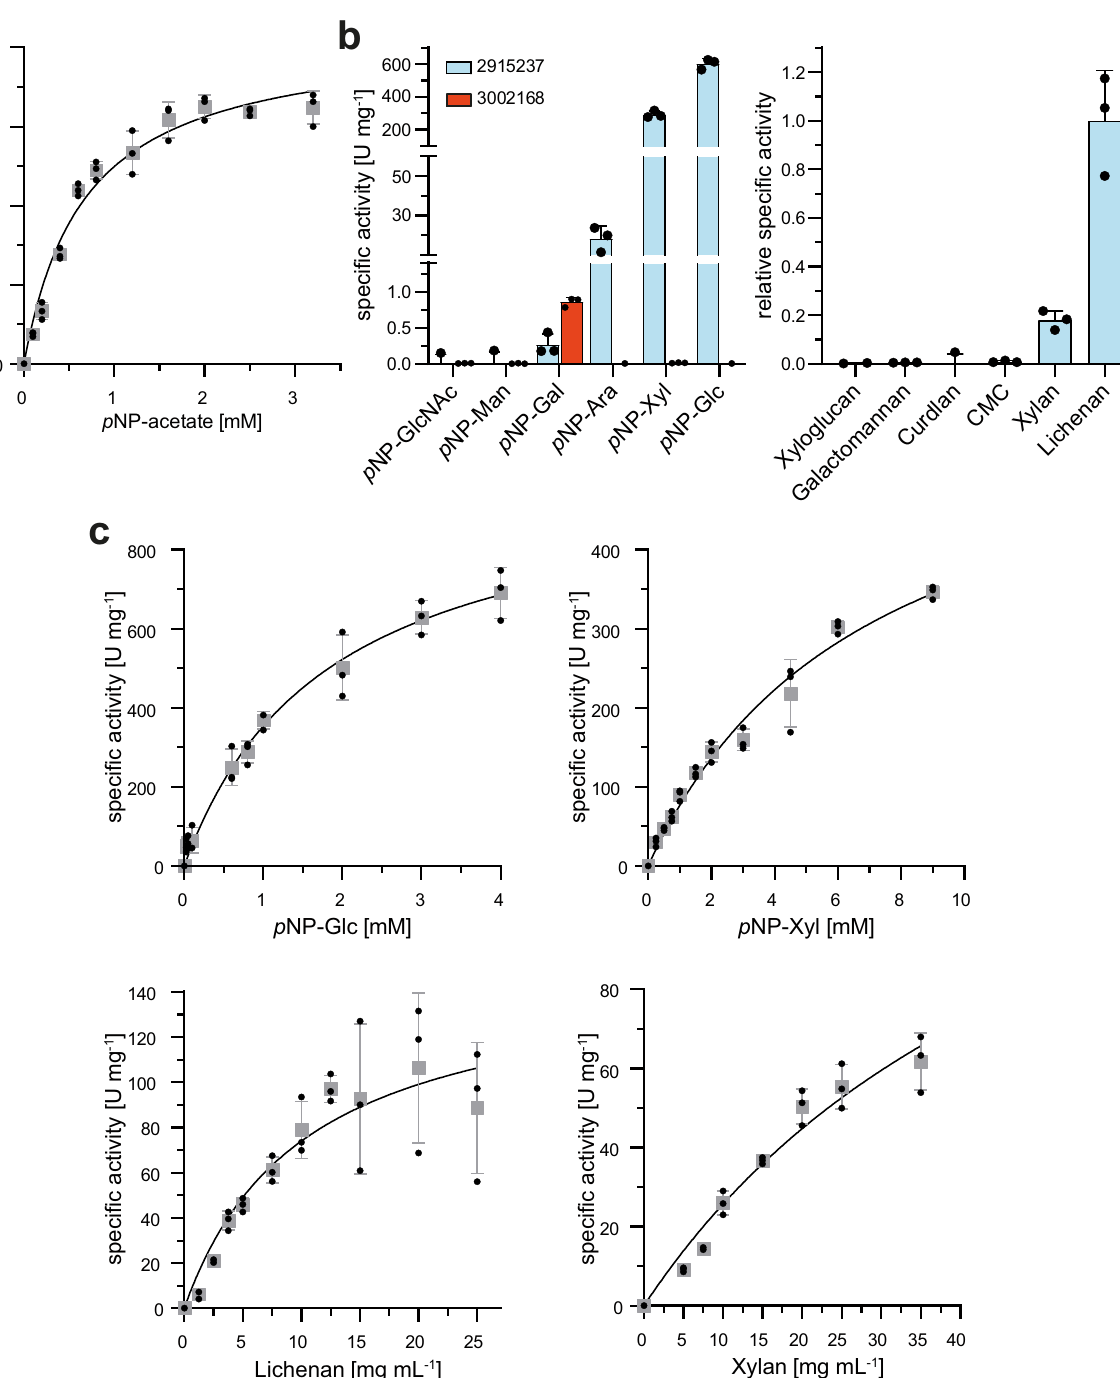
Fig. 4 Biochemical characterization of selected identi fi ed enzymes. a Phchr2 | 126075 was heterologously produced in K. lactis and activity was con fi rmed against p NP-acetate by following the release of p NP with a V max of 41.7 U mg − 1 protein and a K M of 0.67 mM. b Substrate speci fi city of Phchr2 | 2915237 and WP_074995790 from S. misionensis . The activity with different p- nitrophenol-based substrates was determined by measuring the release of p NP. The activity on complex polysaccharides was determined via the DNSA assay that quanti fi es the formation of reducing ends upon polysaccharide cleavage. Phchr2 | 2915237 displayed the highest activities with p NP-Glc, p NP-Xyl, lichenan, and beech wood xylan, while WP_074995790, a close homolog of Phchr2 | 3002168 showed activity only with p NP-Gal as a substrate with a speci fi c activity of 0.85 U mg − 1 protein. c Kinetic characterization of Phchr2 | 2915237 using p NP-Glc, p NP-Xyl, lichenan, and beech wood xylan as substrates. All activity measurements were performed in triplicate ( n = 3), mean values are shown and the error bars indicate the standard deviation